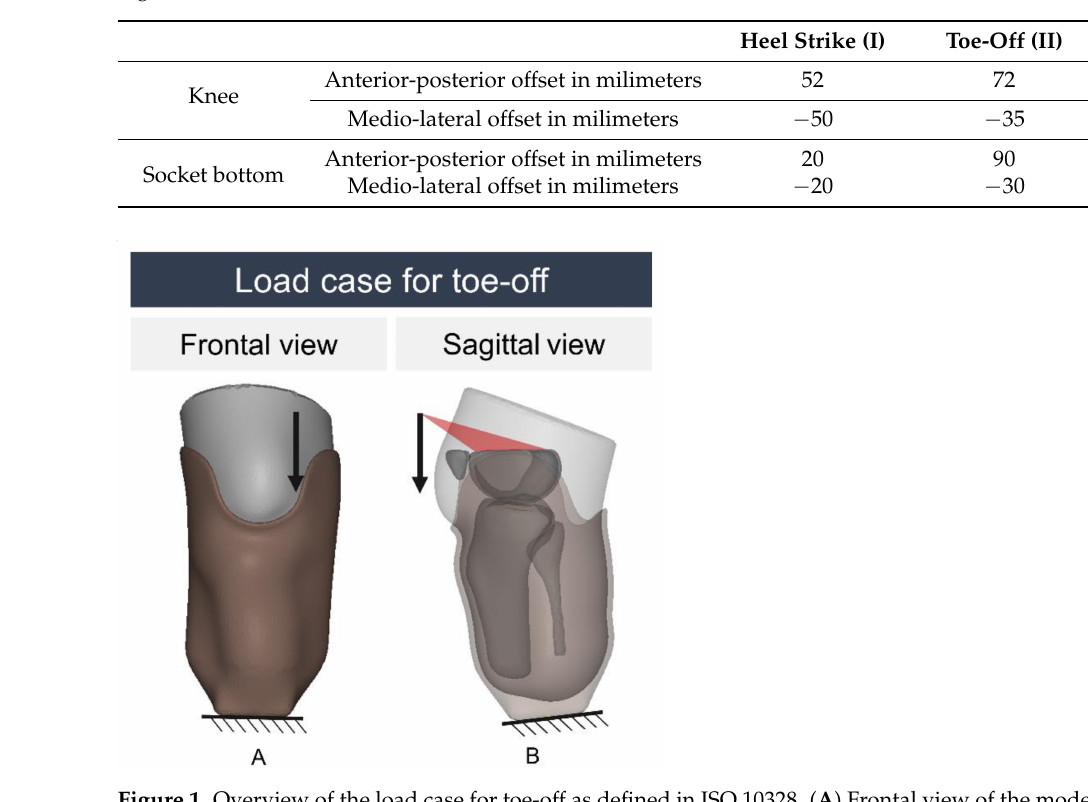
Table 2. Description of the configuration of the socket model relative to the (vertical) line of action of the applied force. The offsets for the knee and socket bottom of a right leg were in accordance with ISO 10328 for test loading level P5. Posterior and medial are defined as positive. Please also see Figure 1 for an overview of the orientation of the socket.